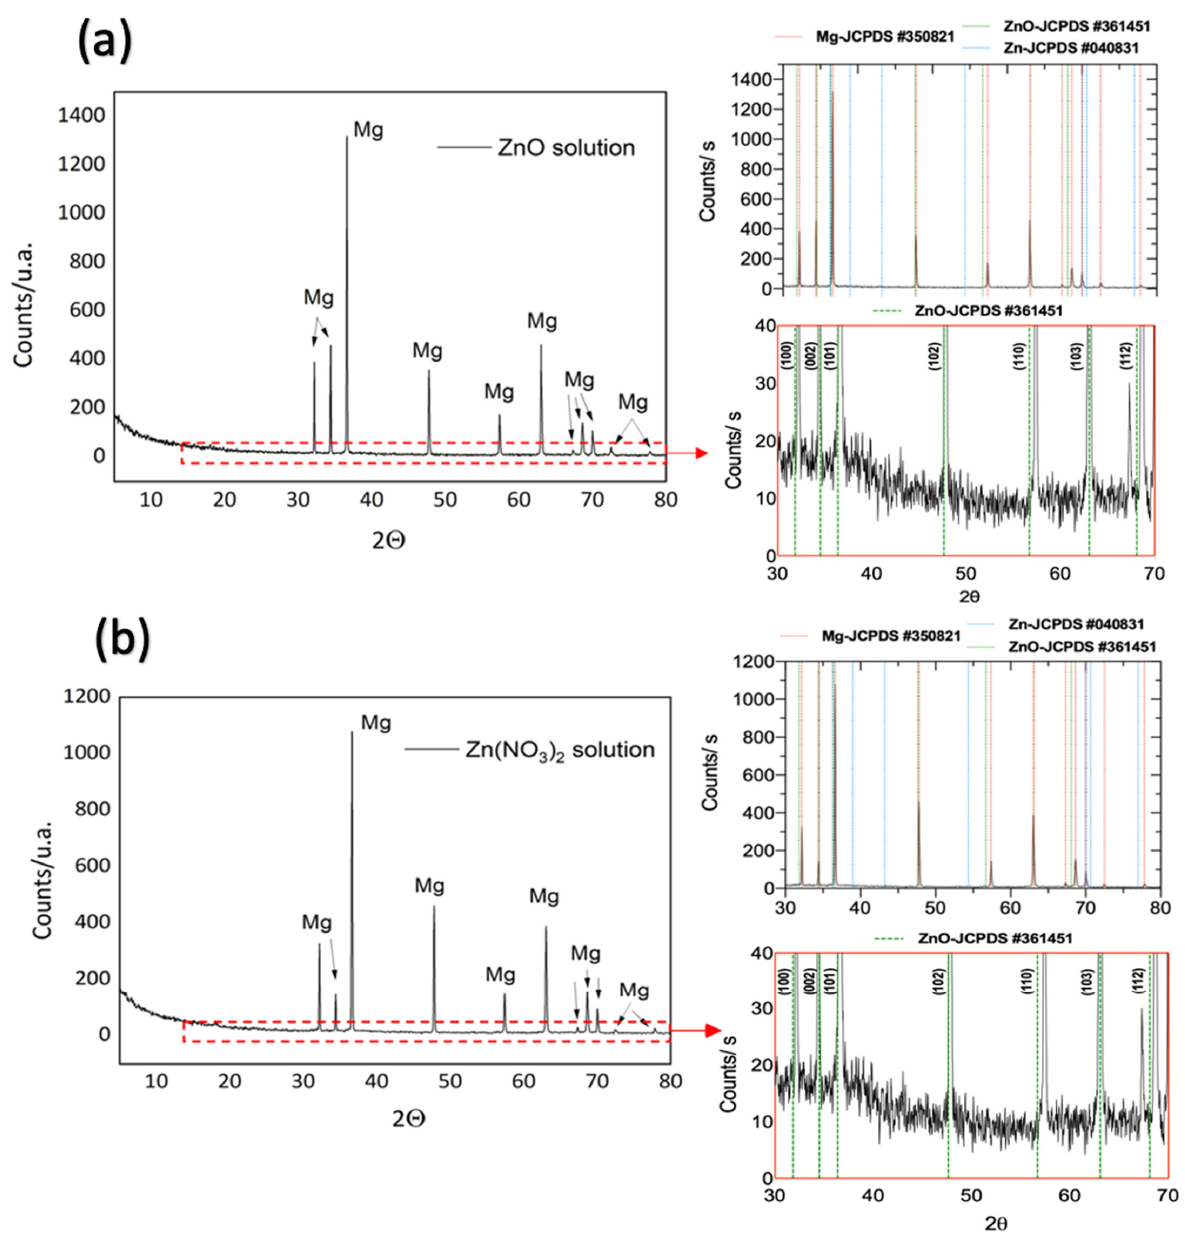
Figure A1. XRD spectra of ZnO-NPs electroless deposits on Mg–Ca0.3 surface achieved from 10 − 3 M solutions of ZnO ( a ) and Zn(NO 3 ) 2 ( b ).